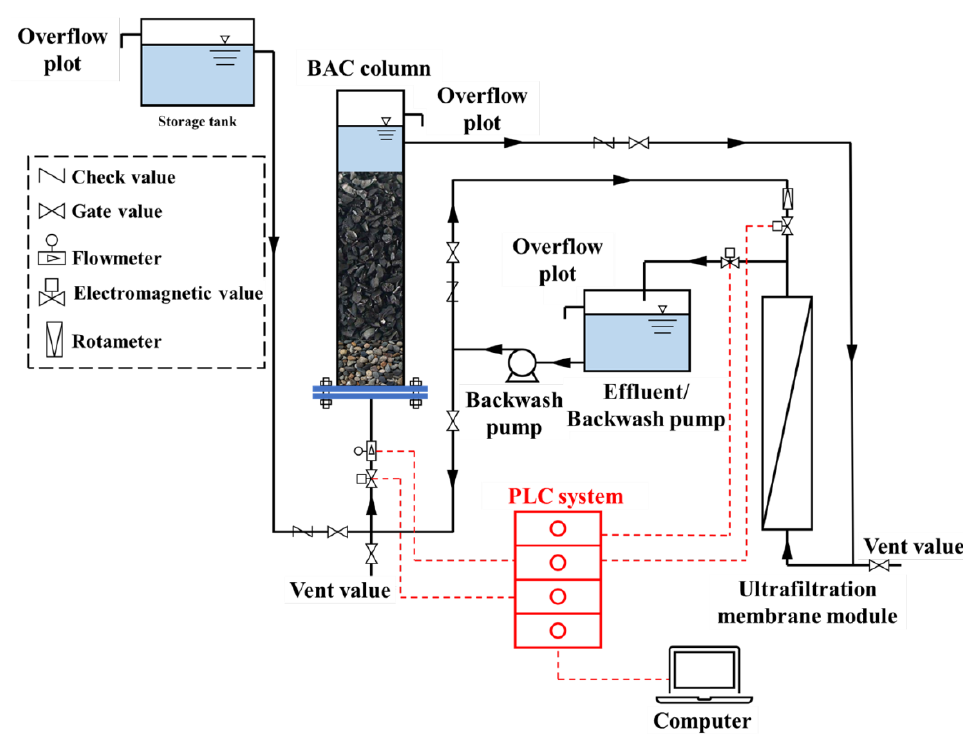
Figure 1. Schematic diagram of the experimental set-up.